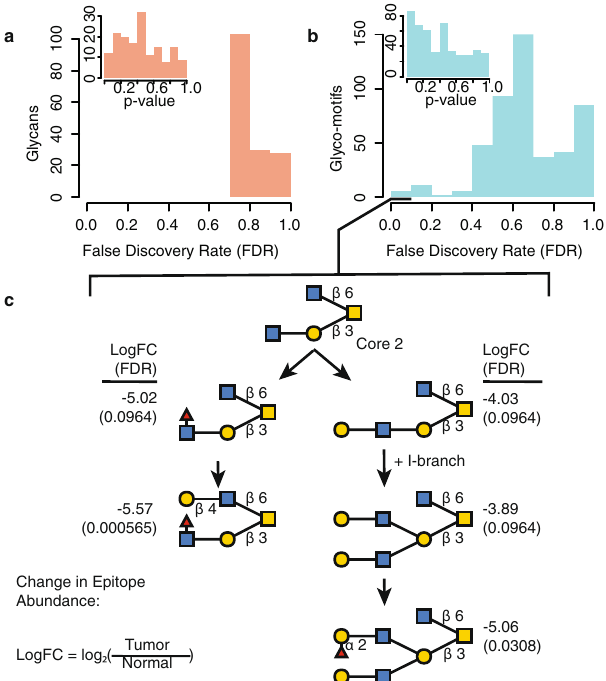
Fig. 7 Increased power for identifying diagnostic markers shown through a re-analysis of mucin-type O-glycans from normal, tumor-proximal, and gastrointestinal cancer biopsies, transformed to motif abundance. a , b Welch two-sample t -test P -value and false discovery rate (FDR) distributions for glycan abundance and glyco-motif abundance. c We found multiple core 2 substructures depleted in gastrointestinal cancer relative to normal tissue. Not all linkages are speci fi ed, only those relevant to the substructure de fi nition. The information of log fold changes (logFC) and the FDR are presented next to each substructure. Source data are provided as a Source data fi